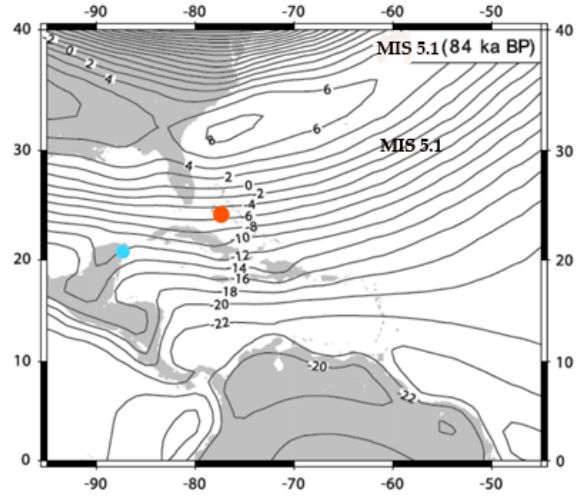
Figure A1. Tide amplitude and POS accretion, redrawn from [29].